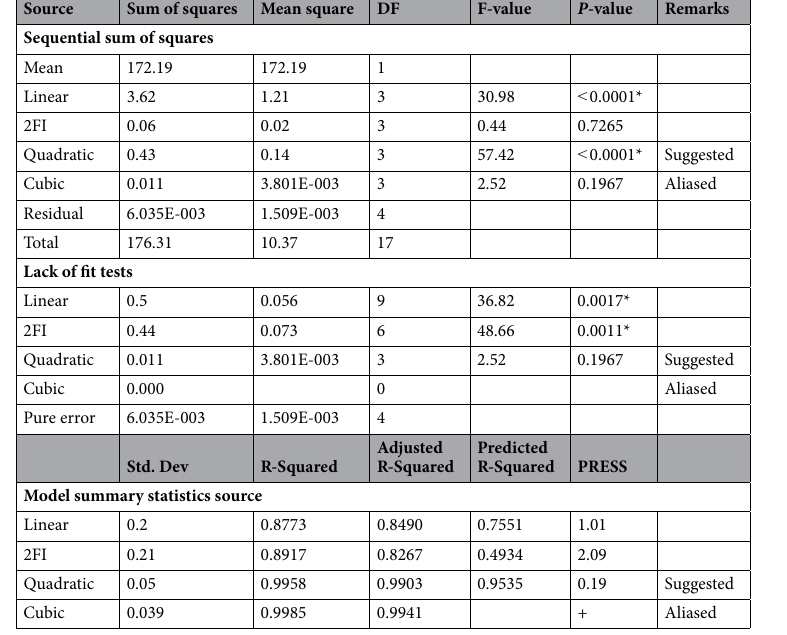
Table 4. Sequential model fitting for the yield. *statistically significant: p ˂ 0.05.